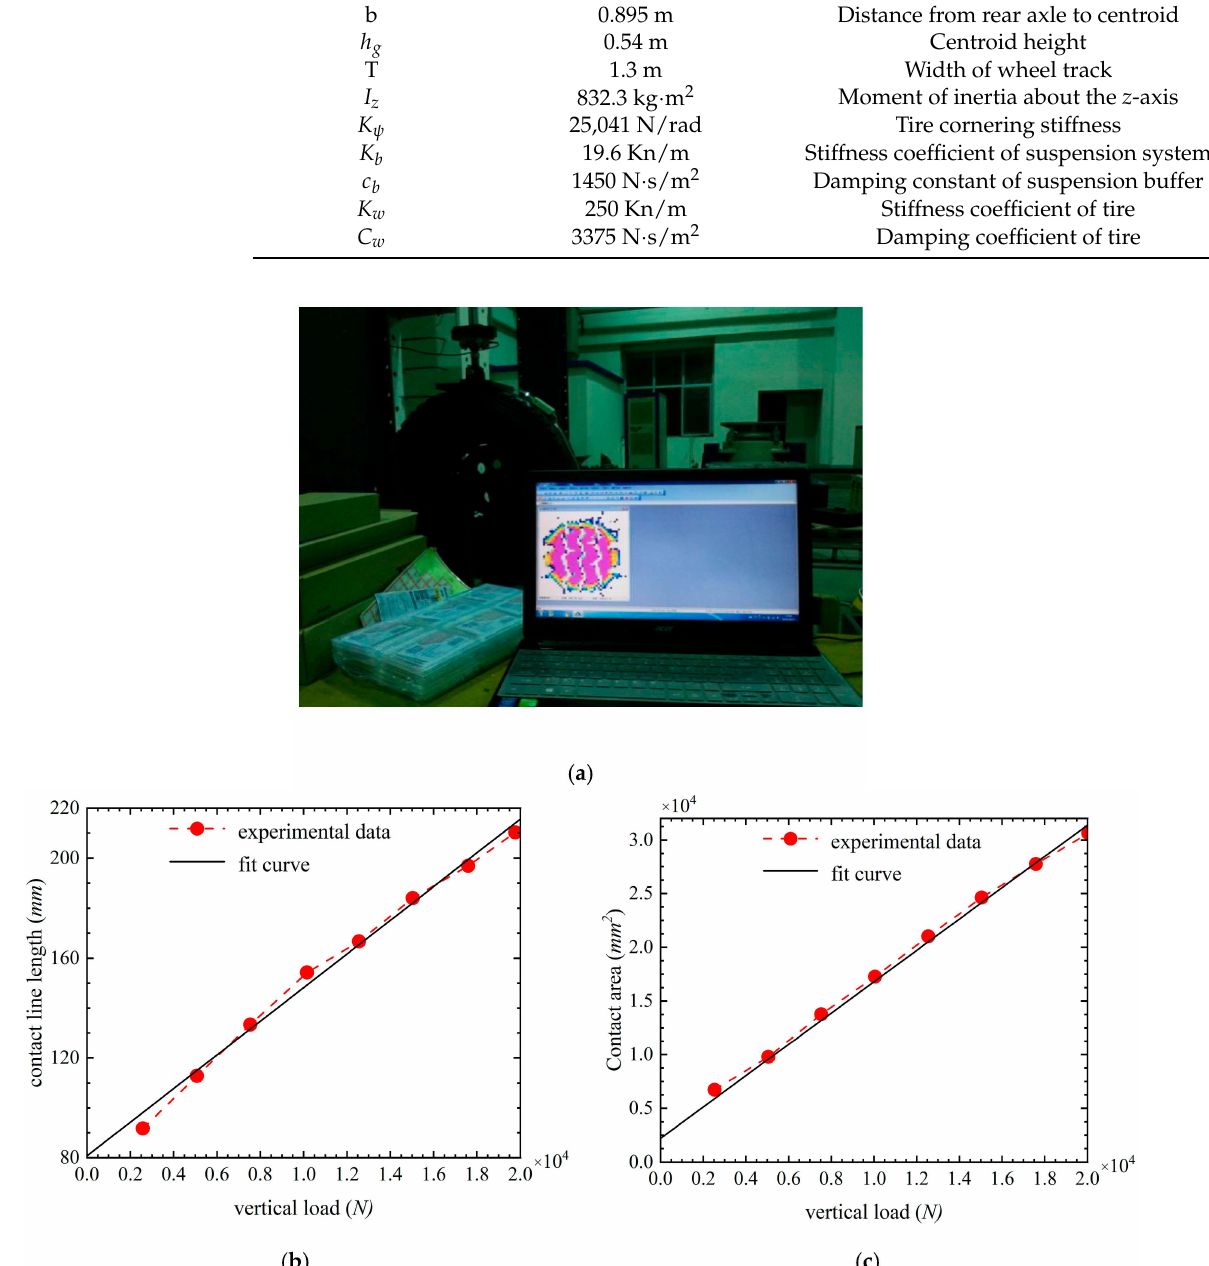
Figure 2. Experiment of tire and vertical load. ( a ) Experimental operation. ( b ) Contact length curve fitting. ( c ) Contact area curve